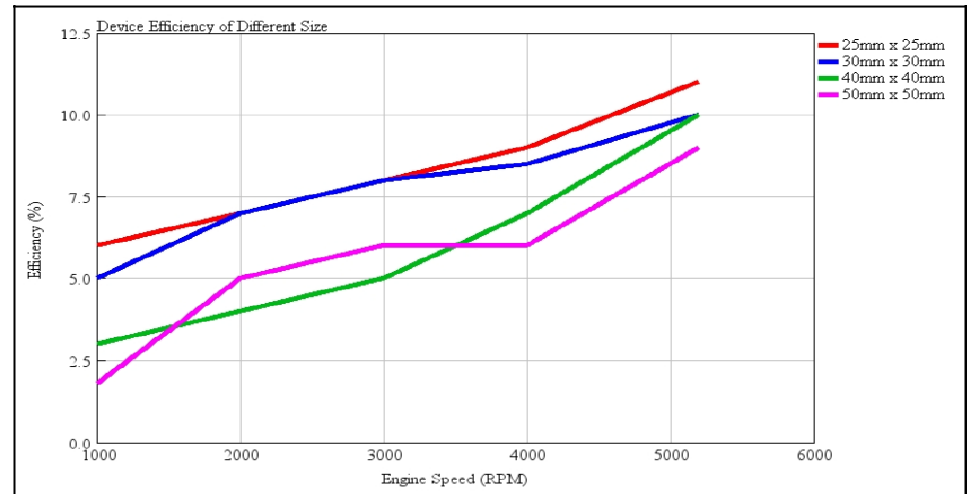
Figure 17. Device efficiency of different module size (1 module).